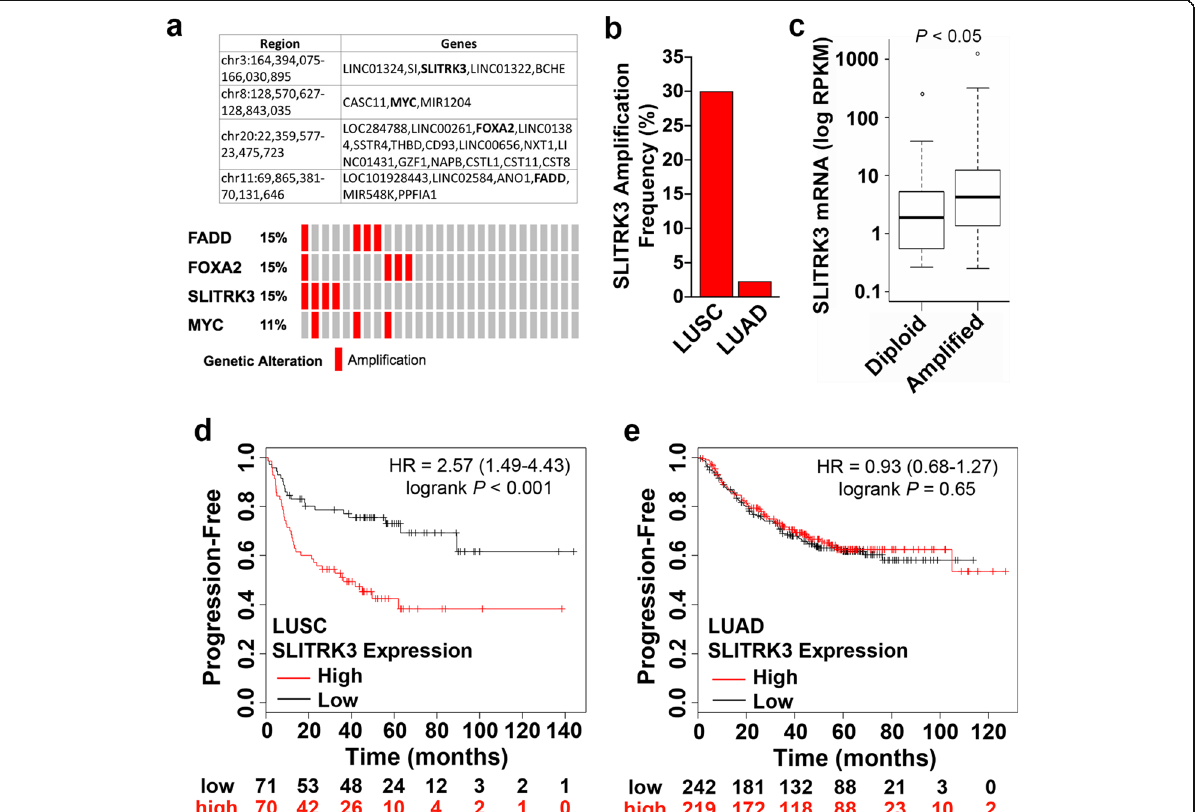
Fig. 1 SLITRK3 amplification, overexpression and association with poor outcomes in patient data sets. (a) Results of GISTIC analysis of aCGH data comprising brain metastasis samples from 27 NSCLC patients identified significantly recurring focal copy number amplification of SLITRK3. Top panel , table listing the order of genes localized within significantly amplified regions. Lower panel, the frequency of events per specimen. (b) Frequency of SLITRK3 gene copy number amplification in LUSC and LUAD samples. (c) Concordance between SLITRK3 amplification and increased SLITRK3 gene expression in LUSC samples. (d) Kaplan- Meier plots displaying the association between high SLITRK3 mRNA expression and decreased time to first progression, specifically for LUSC. (e) Kaplan-Meier plot of SLITRK3 mRNA expression and decreased time to first progression data for